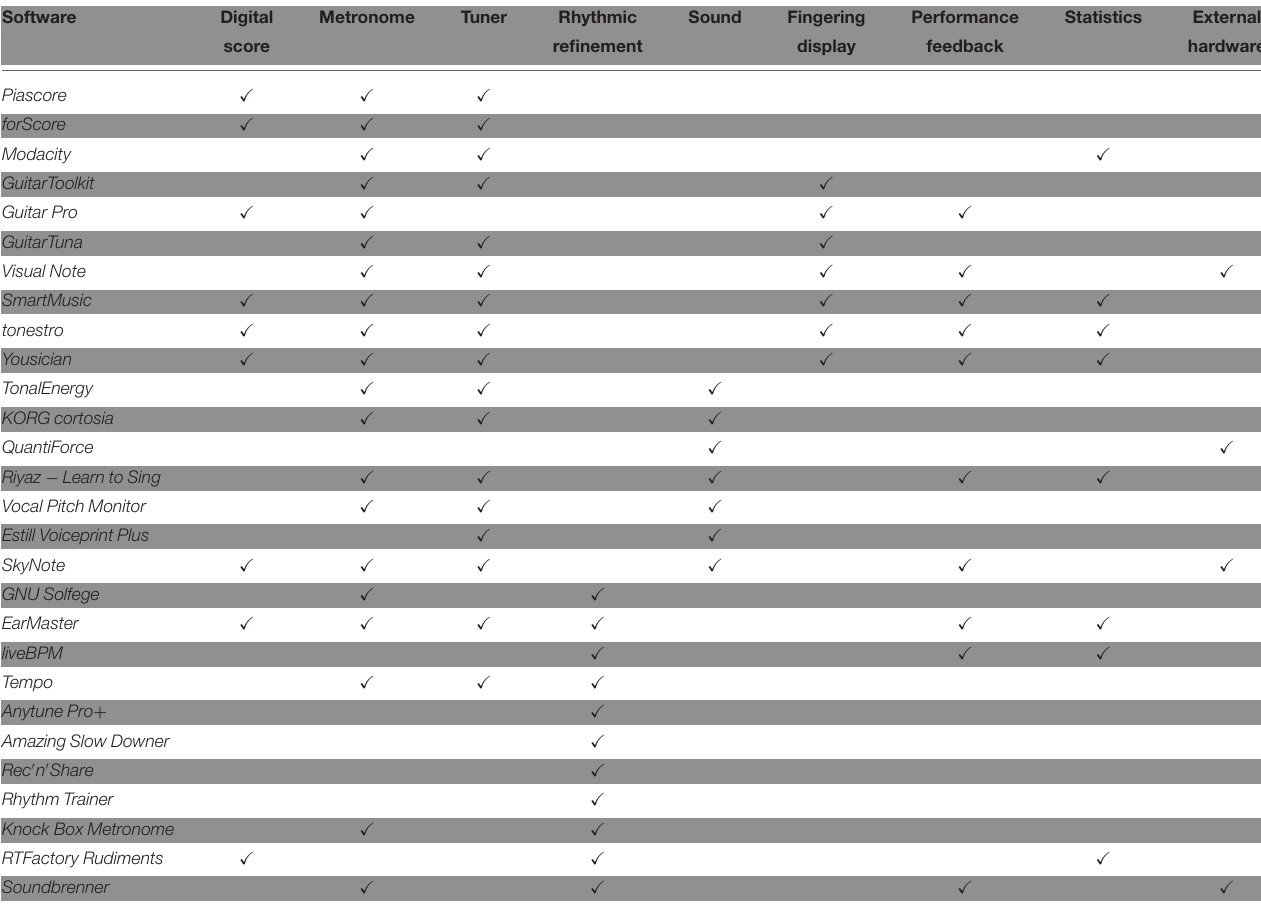
TABLE 1 | List of software in support of music instrument learning classified according to the provided macro-functionalities. Software Digital Metronome Tuner Rhythmic Sound Fingering Performance refinement display feedback